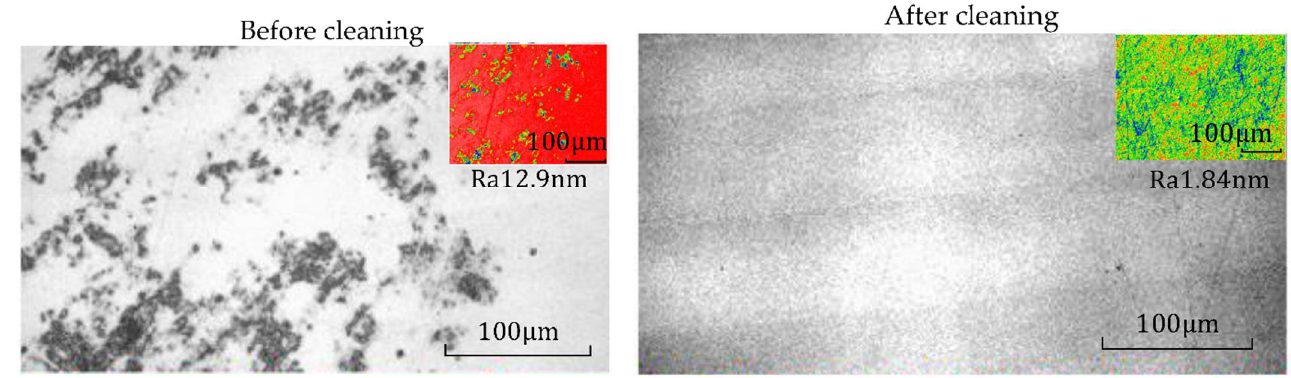
Figure 15. Surface roughness of a modified layer before and after ultrasonic cleaning.